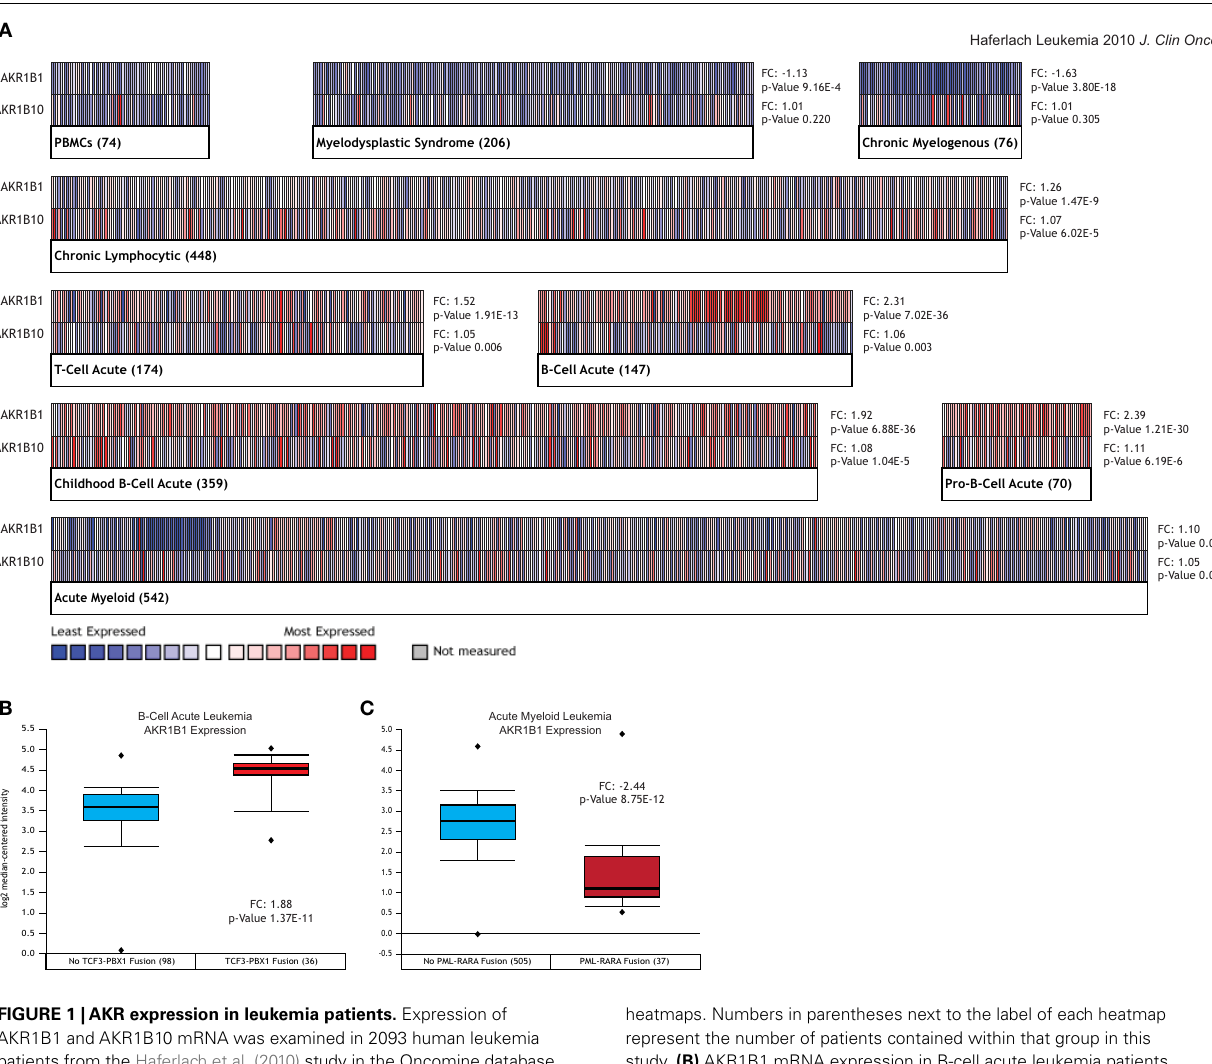
heatmaps. Numbers in parentheses next to the label of each heatmap represent the number of patients contained within that group in this study. (B) AKR1B1 mRNA expression in B-cell acute leukemia patients without (blue box) and with (red box) the presence of theTCF3-PBX1 fusion gene. (C) AKR1B1 mRNA expression in acute myeloid leukemia patients without (blue box) and with (red box) the presence of the PML-RARA fusion